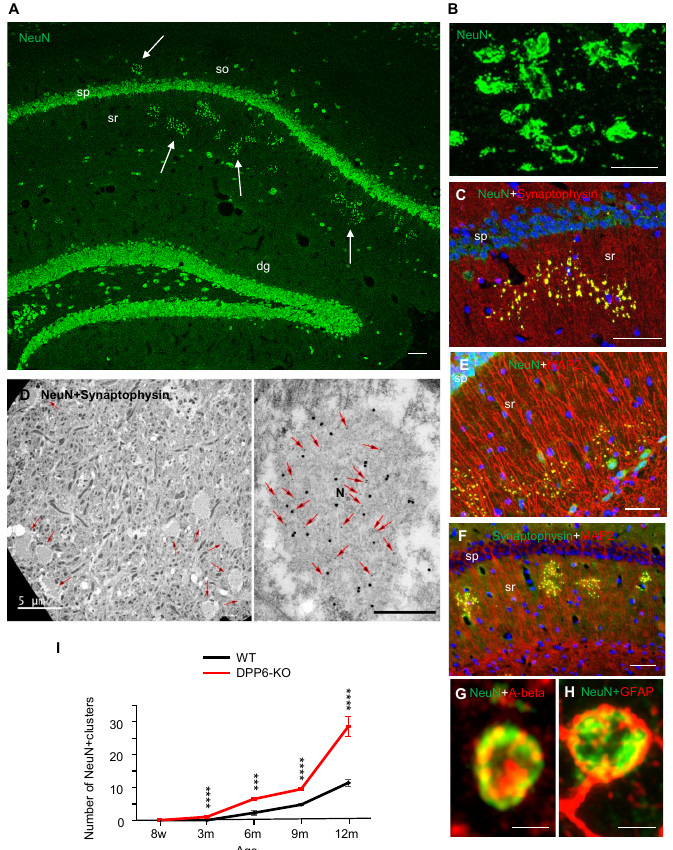
Figure 4. Novel large clusters of NeuN+ puncta are found in the hippocampus of DPP6-KO mice. In the CA1 region of the hippocampus of 12-month-old DPP6-KO brain sections, ( A ) immunofluores- cence (IF) labeling for NeuN (green) is concentrated not only in the neuronal somatic layer but also in novel structures made of enlarged, variable puncta formed in clusters (arrows). Scale bar = 100 µ m, ( B ) higher magnification of single clusters from another section. Scale bar = 5 µ m. ( C ) IF for NeuN (green) and synaptophysin (red) show complete colocalization in clusters of the novel large puncta. Scale bar = 50 µ m. ( D ) Immunogold labeling for NeuN and synaptophysin in the deep region of the CA1 of the DPP6-KO mouse; 20 nm gold for NeuN is concentrated within the large swellings (arrows in low magnification image on the left; N in high magnification image on the right), where it colocalizes very well with 10 nm gold for synaptophysin (arrows in high magnification image; all 10 nm gold particles in the image are indicated with the arrows. Scale bar = 500 nm). ( E ) IF for NeuN (green) and MAP2 (red) are partly colocalized in the large novel puncta clusters, with MAP2 on the periphery of most NeuN+ puncta and throughout some of them; MAP2 also is evident in the apical dendrites of the CA1 pyramidal neurons that overlap with the clusters. Scale bar = 50 µ m. ( F ) IF shows MAP2 (red) and synaptophysin (green) partly colocalized in clusters of puncta. Scale bar = 50 µ m. ( G ) IF shows A β (red) partially colocalized with the novel NeuN+ (green) structures. Scale bar = 2 µ m. ( H ) IF shows that the GFAP+ astrocytes can directly surround the novel NeuN+ large puncta, sometimes as distinct ring-shaped processes. Scale bar = 2 µ m. ( I ) Graph comparing the number of novel clusters in the CA1 region of the hippocampus during development from 8-week to 12-month-old mice in WT and DPP6-KO mice. From 8-week to 12-month-old, labeling in aged DPP6-KO mice is significantly increased compared to WT (*** = p < 0.001, **** = p < 0.0001). Nuclei were counterstained with DAPI in blue. dg, dentate gyrus; so, stratum oriens; sp, stratum pyramidale; sr, stratum radiatum. Lin et al., 2020